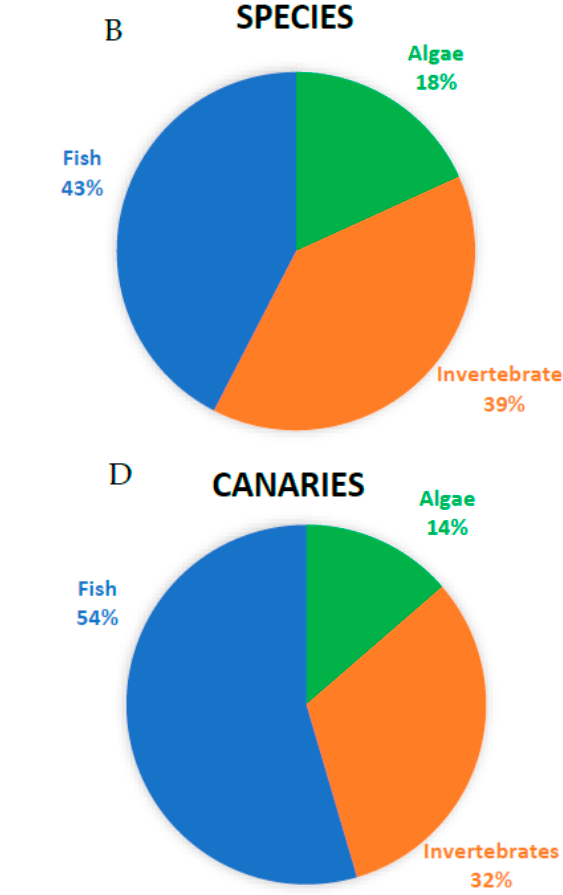
Figure 3. The proportion of groups/taxa recorded in the articles included in the Azores and Canaries systematic review: ( A ) Proportion of studies for each archipelago; ( B ) Proportion of groups/taxa studies among archipelagos; ( C ) Proportion of groups/taxa studies in the Azores; ( D ) Proportion of groups/taxa studies in the Canaries.